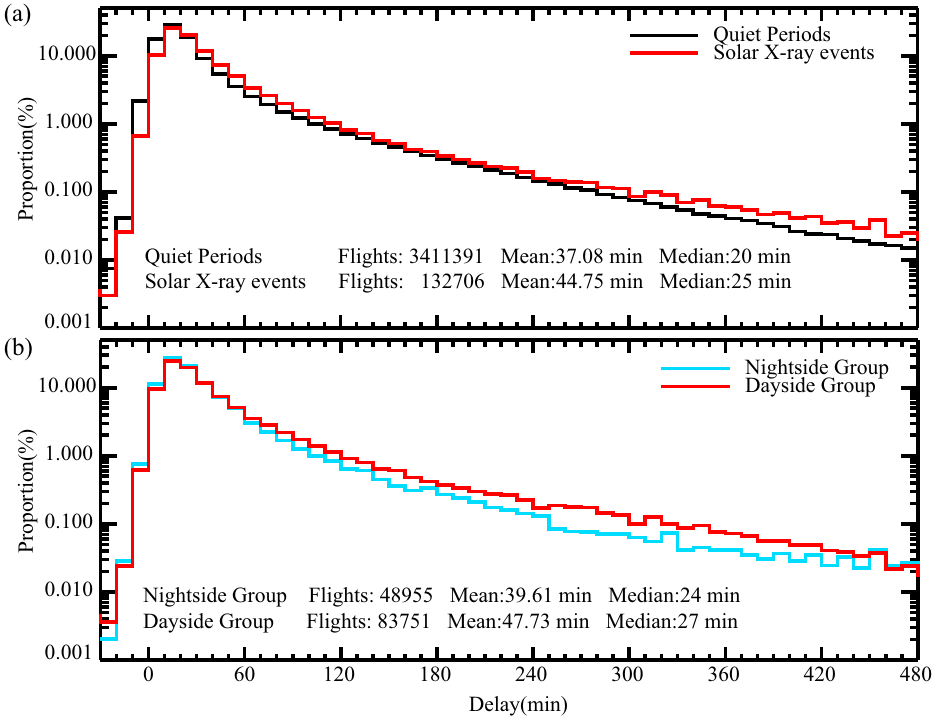
Figure 2. ( a ) The PDF of flight departure delay time during solar X-ray events (red) and quiet periods (black) averaged over five airports. ( b ) The PDF of flight departure delay time in the “Dayside Group” (red) and “Nightside Group” (blue) averaged over five